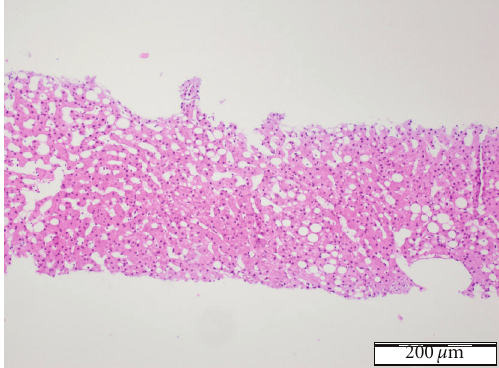
Figure 2: Transbronchial biopsy specimen showed mild interstitial fibrosis and inflammation.